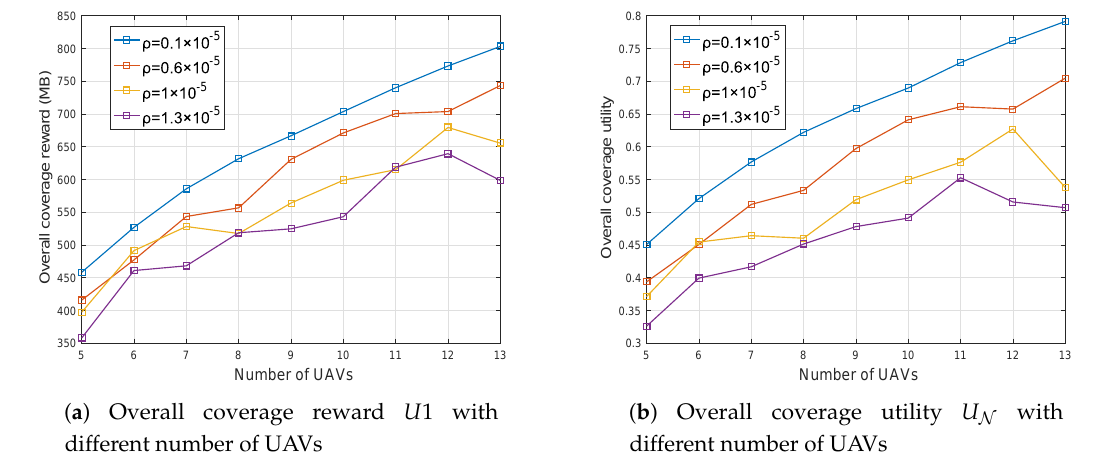
Figure 5. Coverage performance considers the number of UAVs and weighting